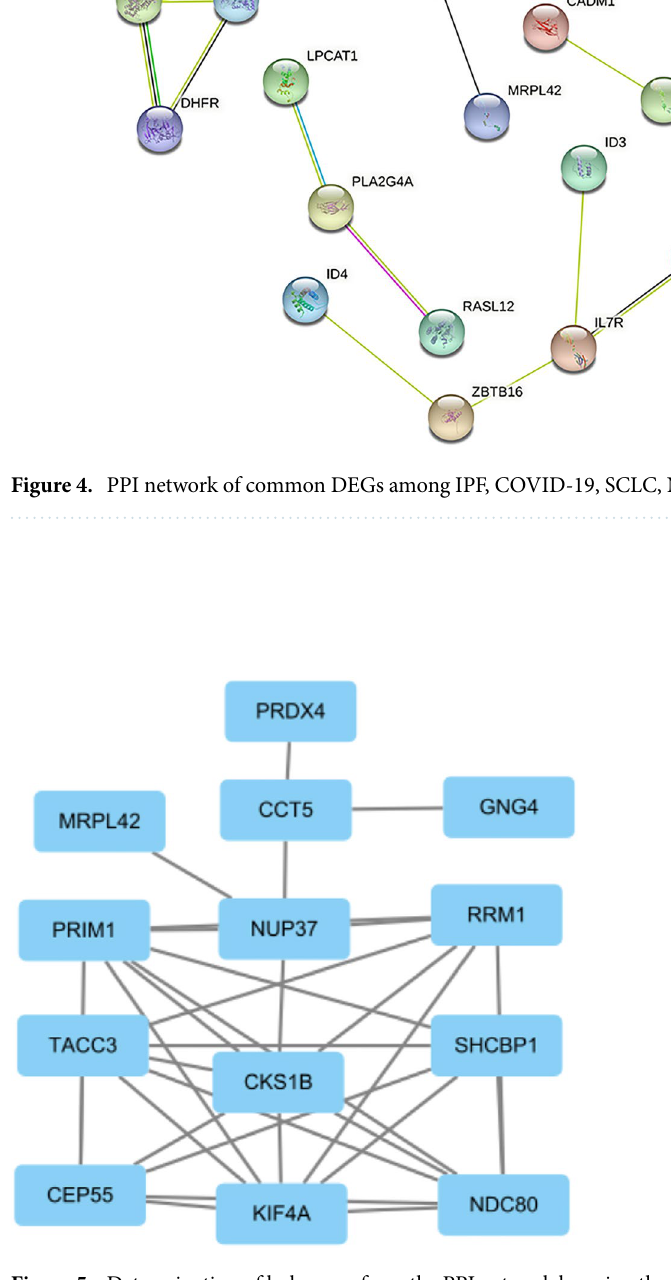
Figure 5. Determination of hub genes from the PPI network by using the Cytohubba plugin in Cytoscape. The latest MCC procedure of the Cytohubba plugin was pursued to obtain hub